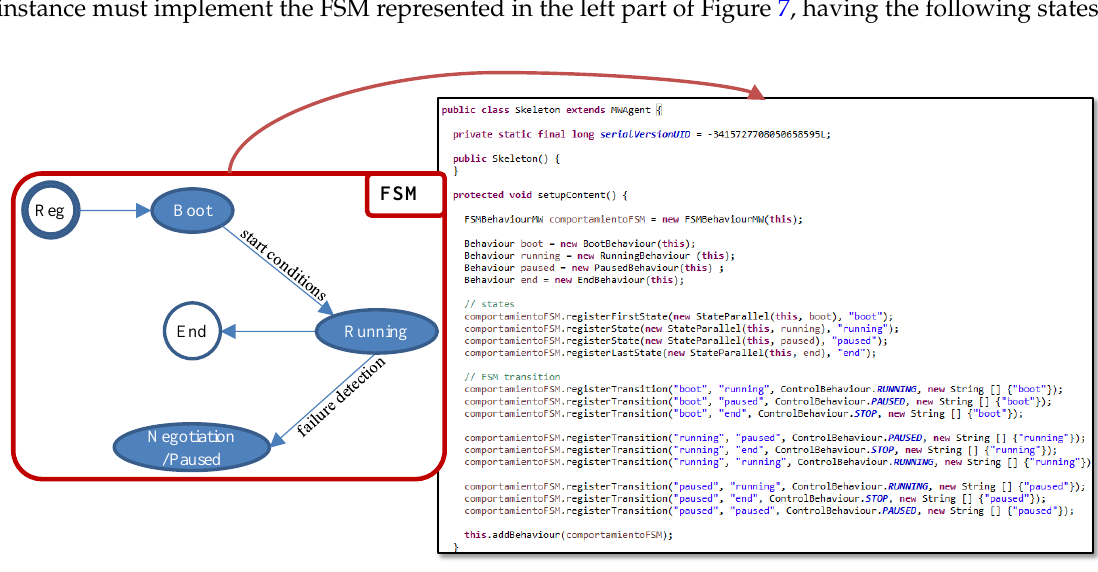
Figure 7. Finite State Machine (FSM) and its Java implementation.